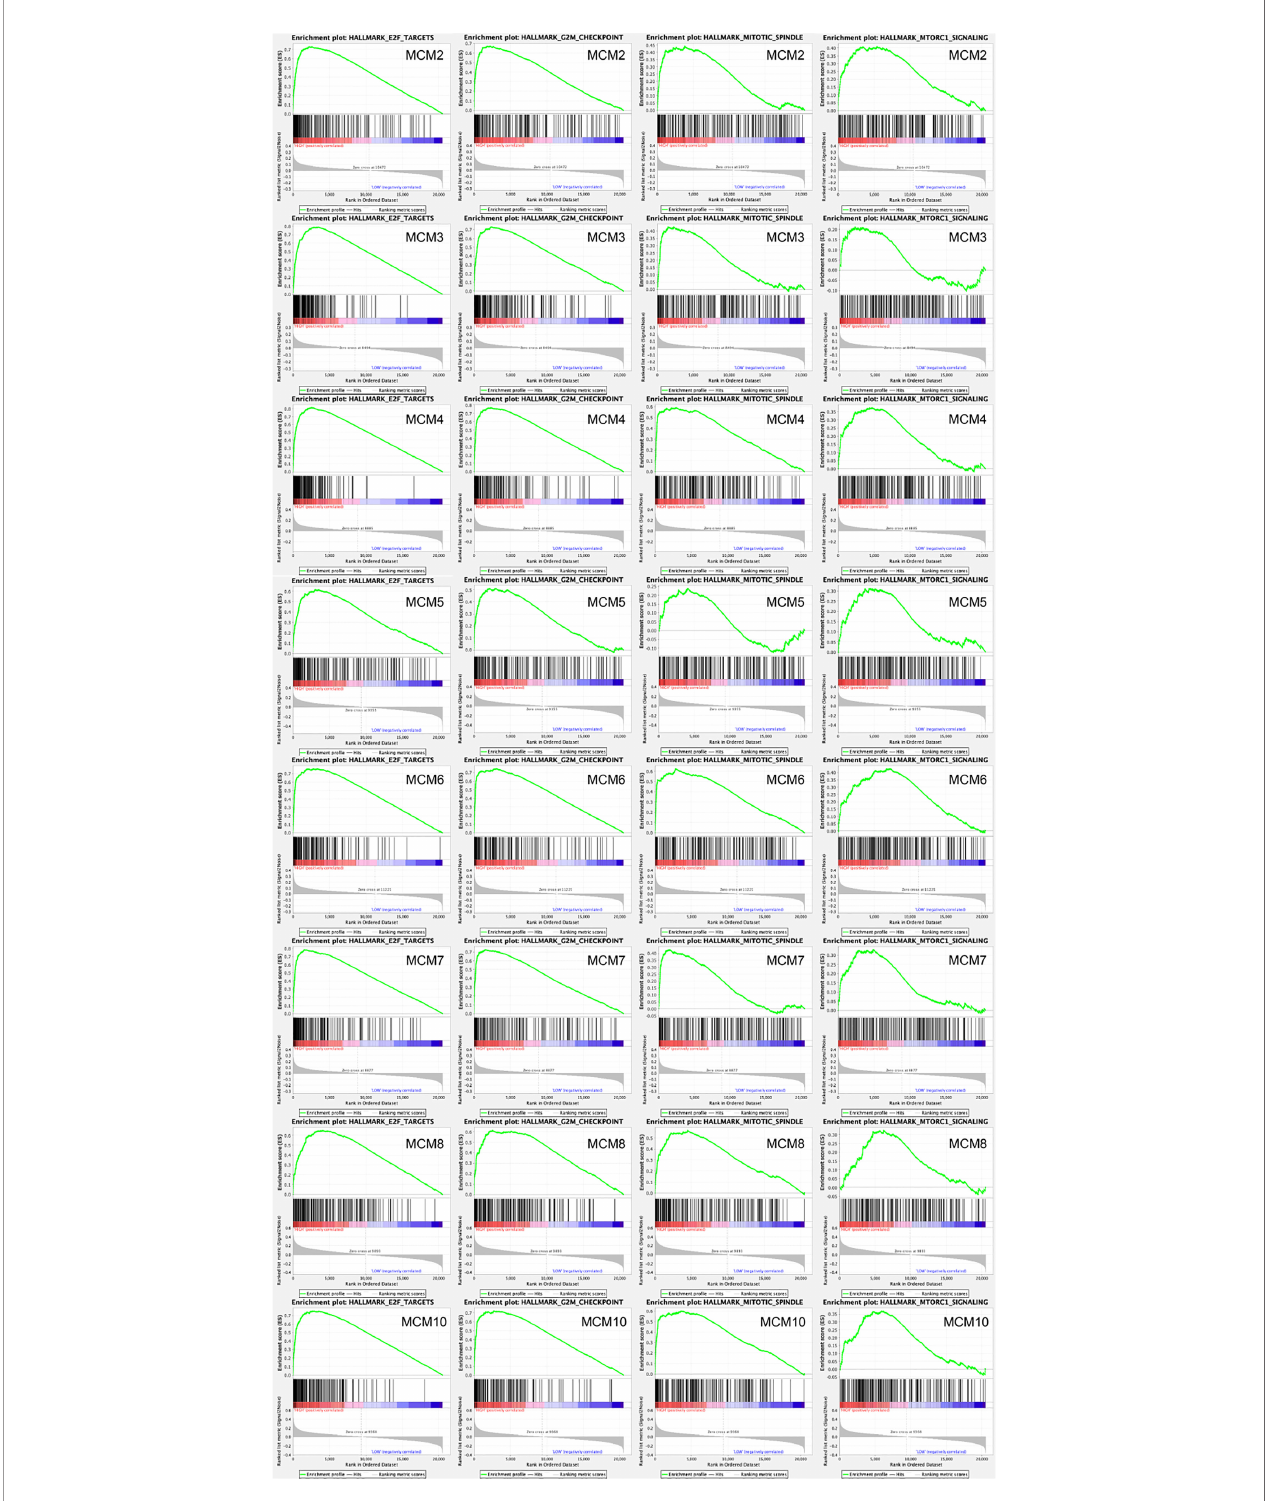
FIGURE 10 | GSEA was used to perform hallmark signaling analysis in MCM s, respectively. A total of 100 signi fi cant genes were obtained from GSEA with positive and negative correlation. GSEA, including MCM2 – 8 and MCM10 , indicated that the most involved hallmark pathways were E2F targets, G2M checkpoint, mitotic spindle, and mTORC1